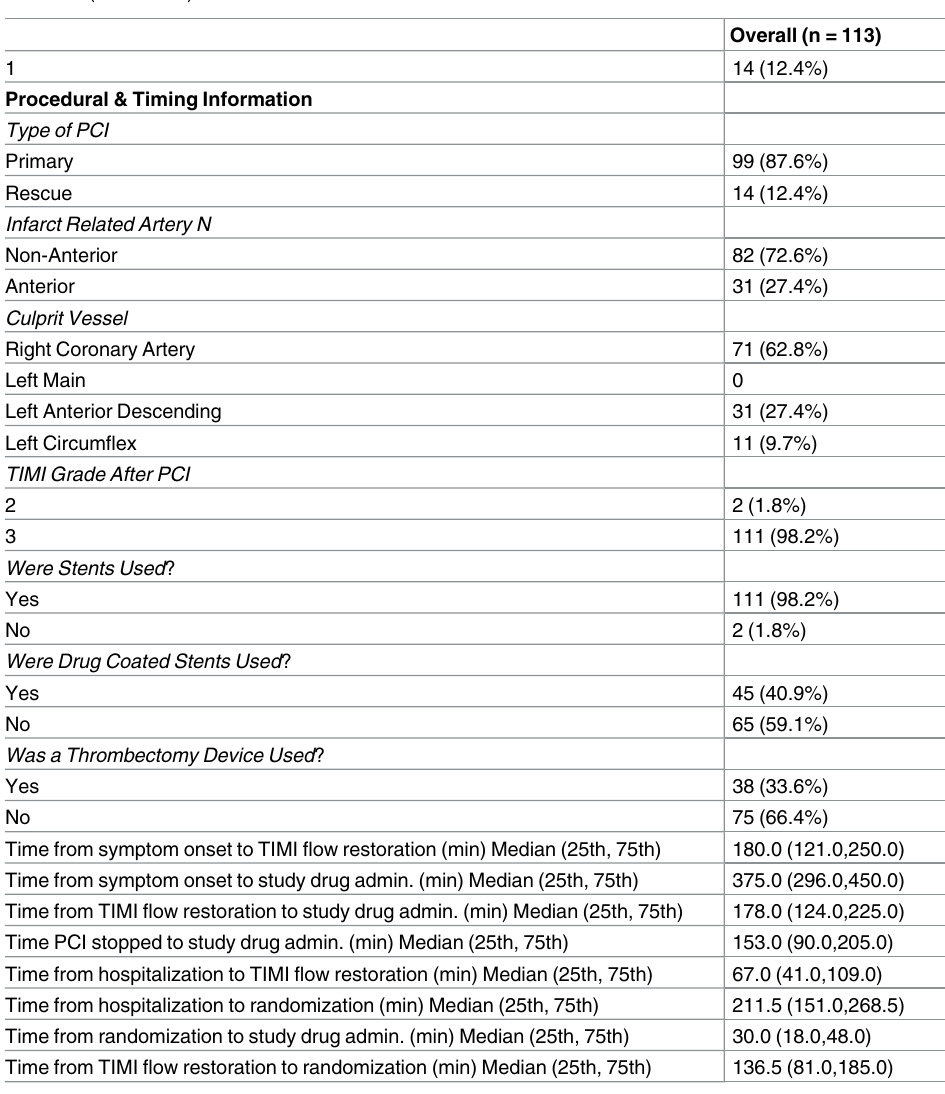
RV infarcts Twenty-three patients (20%) with STEMI exhibited right ventricular infarction. Among the 62 patients with the IRA as the RCA, 21 (34%) experienced right ventricular infarcts (RVI). Addi- tionally, there were two patients who had an infarct in the right ventricle from an IRA that was identified from the LAD and one from the LCx, however, both were left dominant coronary anatomy. (Fig